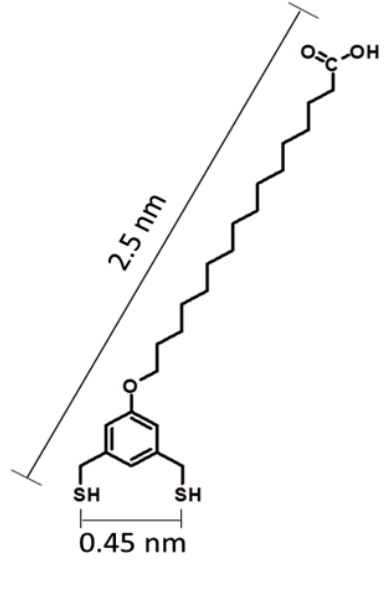
Figure 1. Structure of 16-[3,5-Bis(mercaptomethyl)phenoxy]hexadecanoic acid